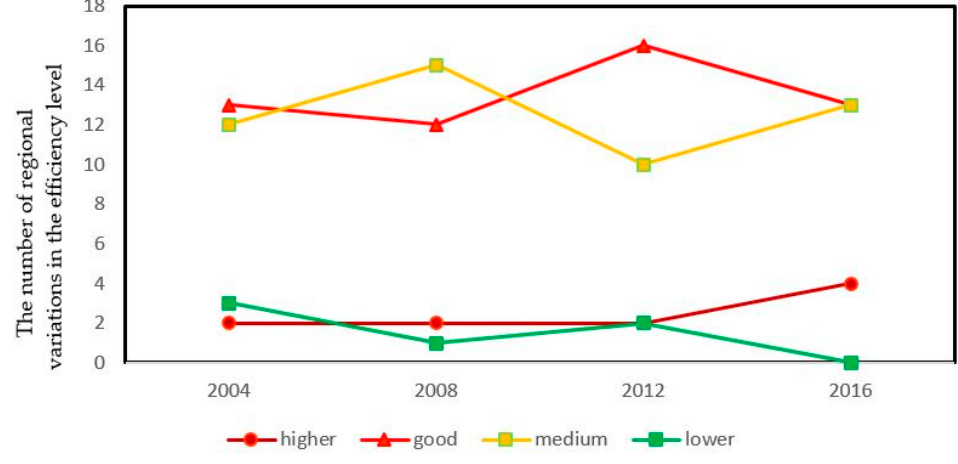
Figure 2. Temporal trend of eco-efficiency of China in 2004, 2008, 2012, and 2016.